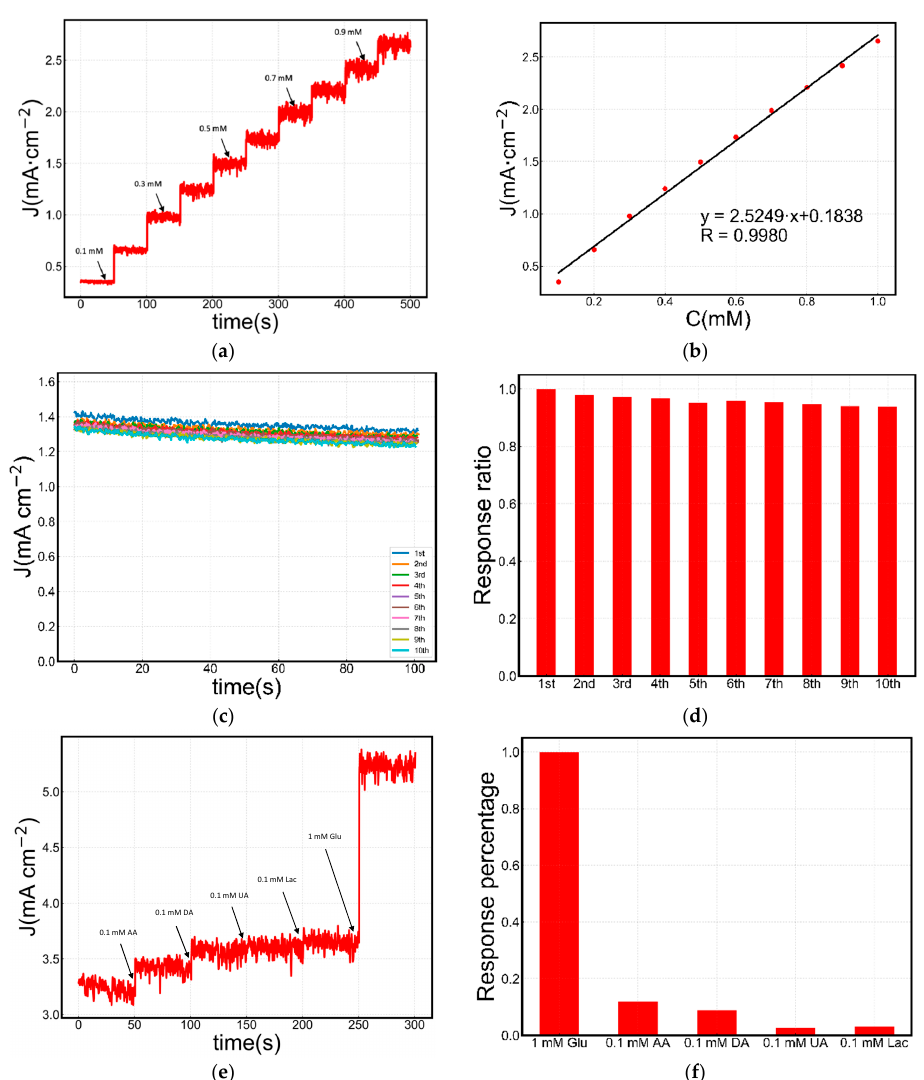
Figure 3. ( a ) Amperometric J–t test with successive addition of glucose at 0.5 V (vs. Ag/AgCl). ( b ) The